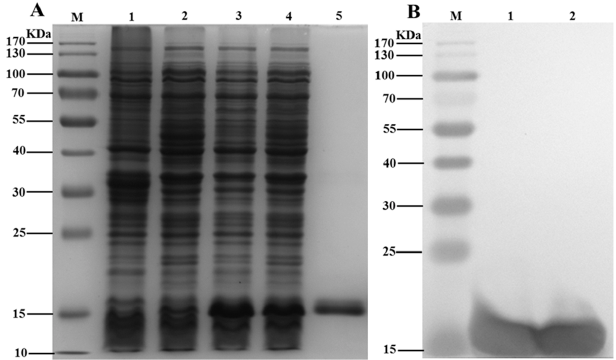
Figure 3. ( A ) Analysis of recombinant ScFerHCH protein using SDS-PAGE. M: molecular weight markers. Lane 1: blank control without insert. Lane 2: negative control without induction. Lanes 3–4: